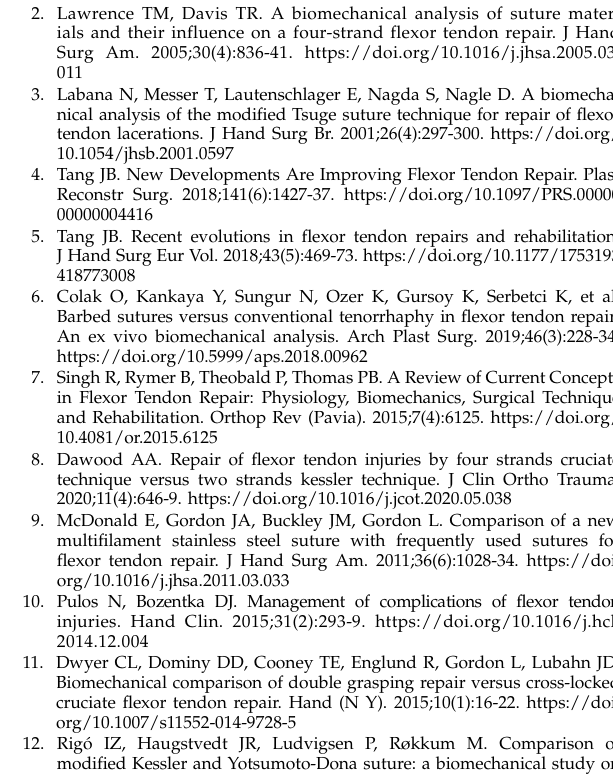
Figure 5 - The time required for the six suture techniques. It took a longer time to perform MK + P, DK + P, and SK + P than to perform single core sutures ( p o 0.05). And the suture time was significantly longer for DK + P and SK + P than MK + P ( p o 0.05). However, there was no significant difference between DK + P and SK + P ( p 4 0.05). * p o 0.05 versus core suture # p o 0.05 versus MK + P. MK, modified Kessler suture without epitendinous suture; DK, double knot Kessler-loop lock flexor tendon suture without epitendinous suture; SK, single knot Kessler-loop lock flexor tendon suture without epitendinous suture; MK + P, modified Kessler suture with epitendinous suture; DK + P, double knot Kessler-loop lock flexor tendon suture with epitendinous suture; SK + P, single knot Kessler-loop lock flexor tendon suture with epitendinous